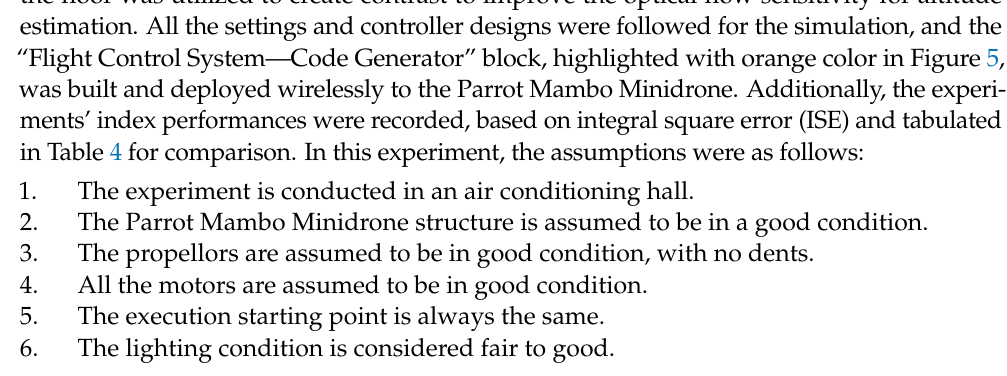
Figure 13. Test field and a Parrot Mambo Minidrone during execution.